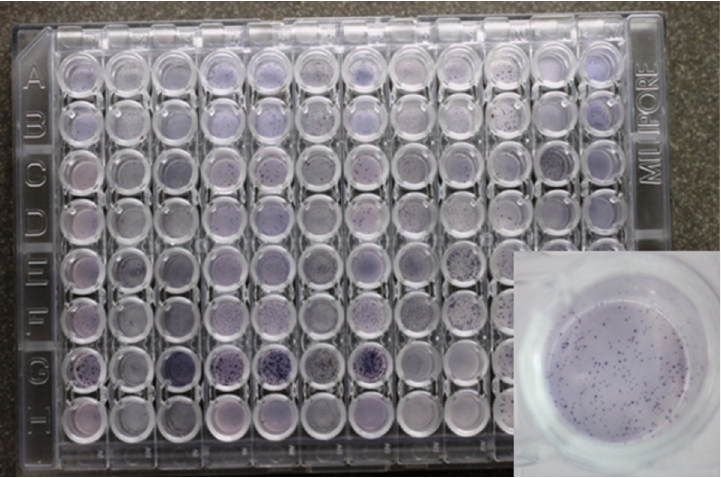
Fig 1. Representative image of PVDF bottomed ELISPOT plates. One well is magnified to illustrate the appearance of the spot forming cells (SFCs) on the PVDF membrane. SFCs were counted using a dissection microscope.